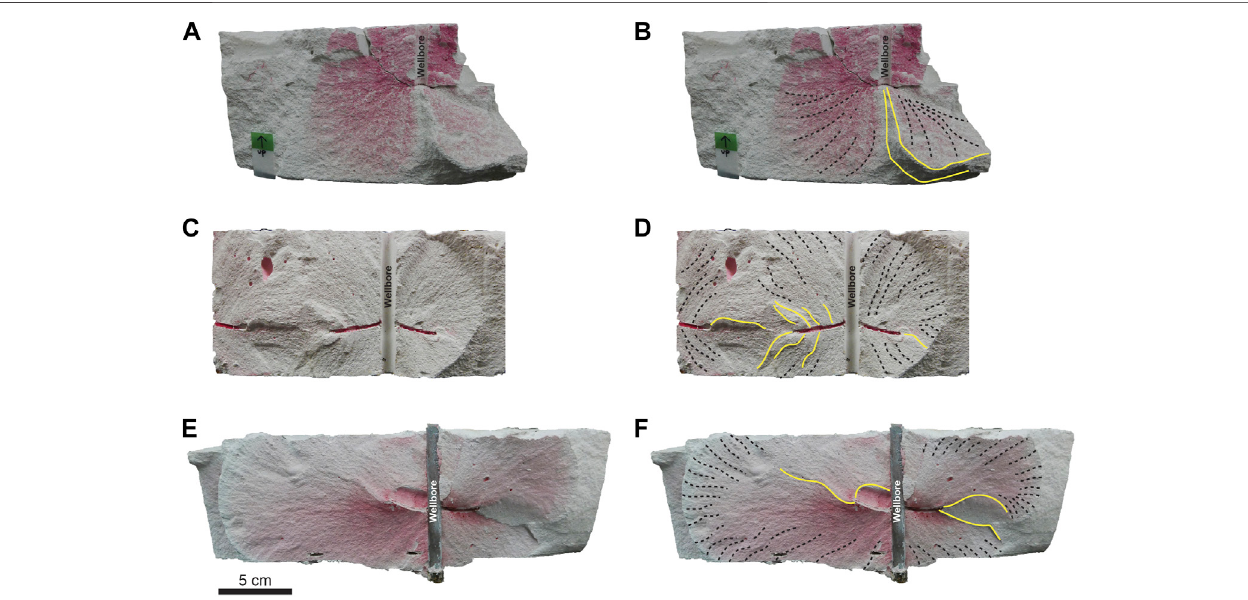
FIGURE 11 | (A) Experimental Block 3 exhibiting two obliquely oriented fractures (stained red) emanating from the base of the wellbore. In (B) these features are highlighted, with plumose and fracture fringes highlighted using black dashed lines, and the gap between the two obliquely oriented fractures is shown with yellow lines. (C) Block13and (E) Block22exhibitfractureirregularitiesemanatingfromtheperforations. (D,F) showthesesameblockswithplumoseandstepfeaturesannotatedas above. Note that the wellbore diameter in each block is 1 cm.